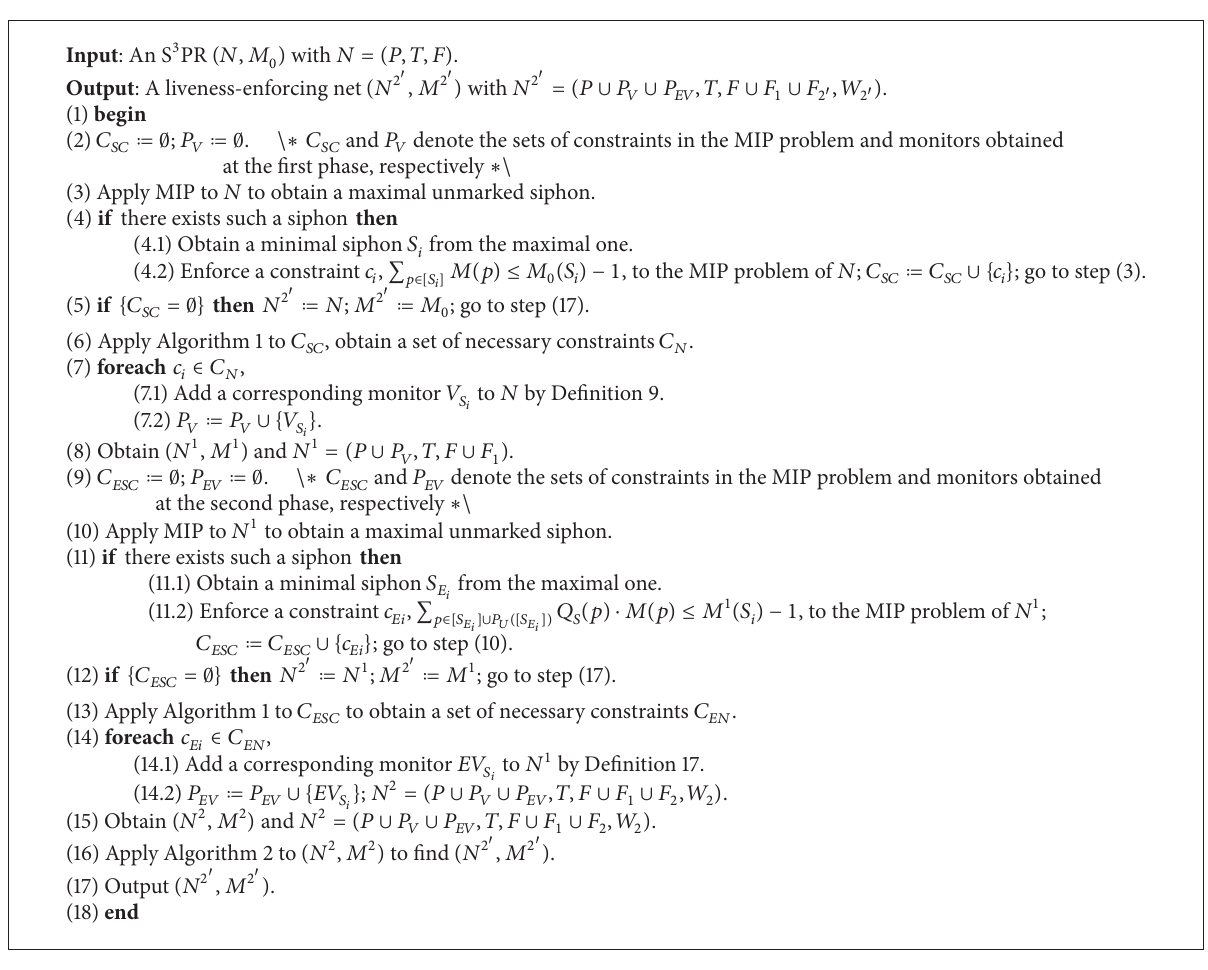
Algorithm 3: A liveness-enforcing policy.